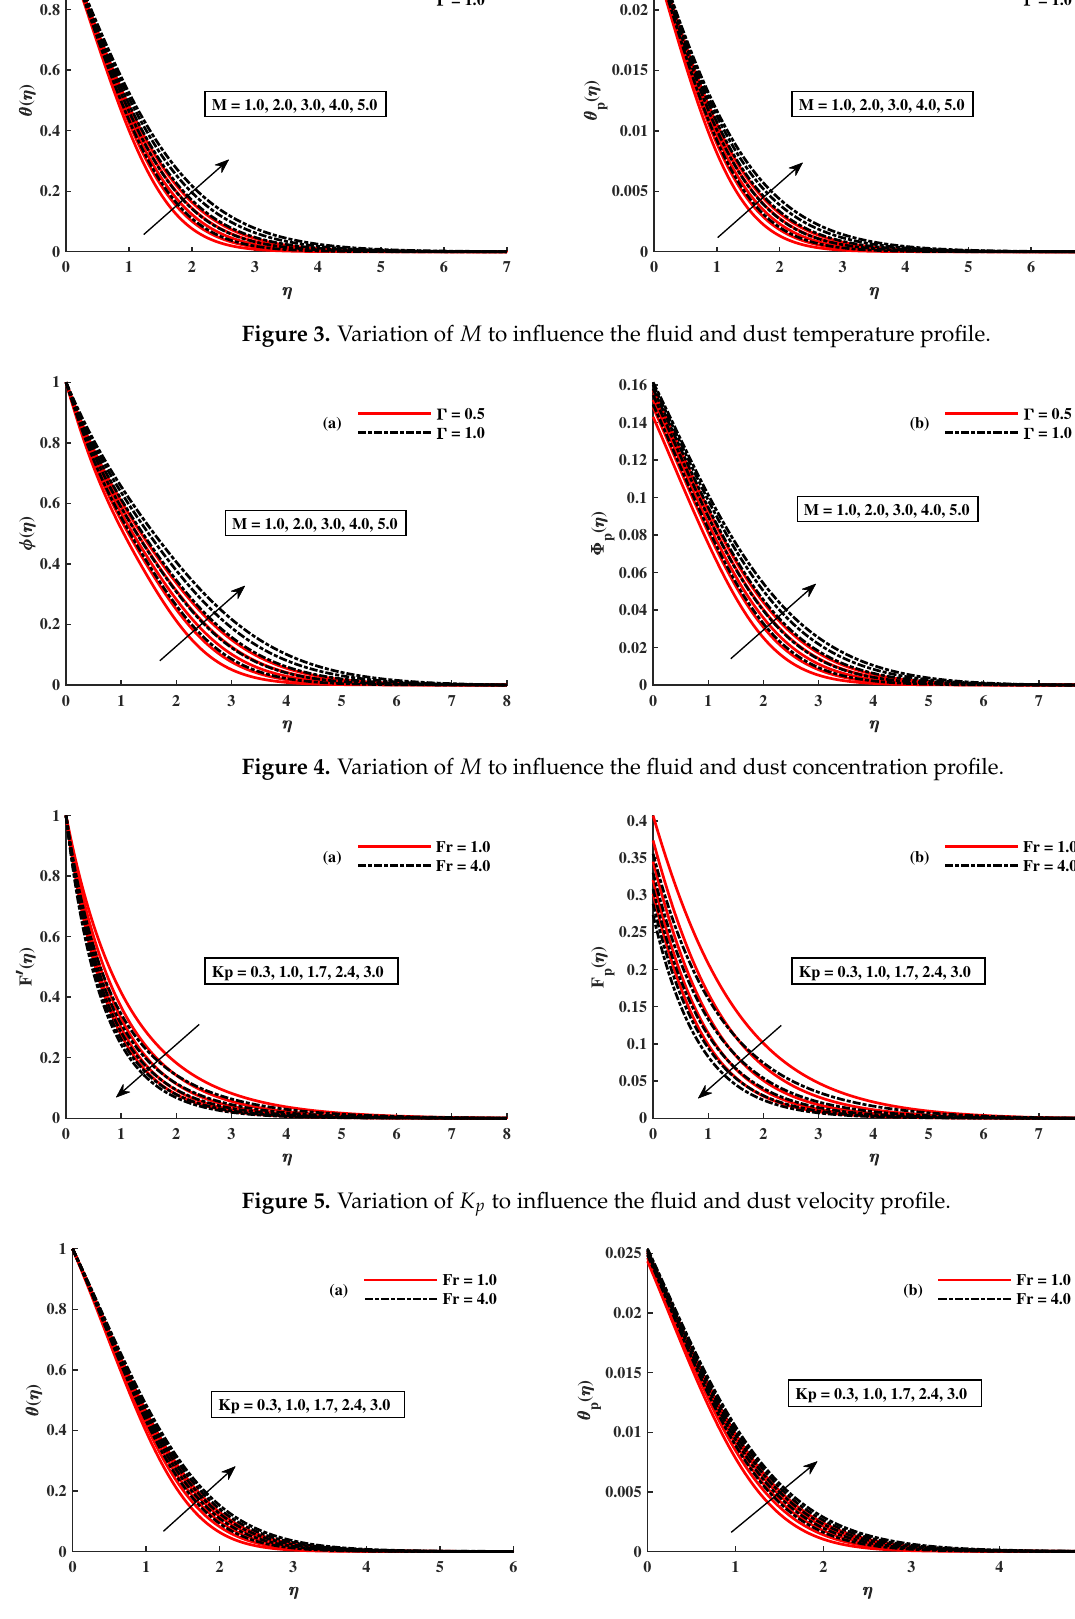
Figure 6. Variation of K p to influence the fluid and dust temperature